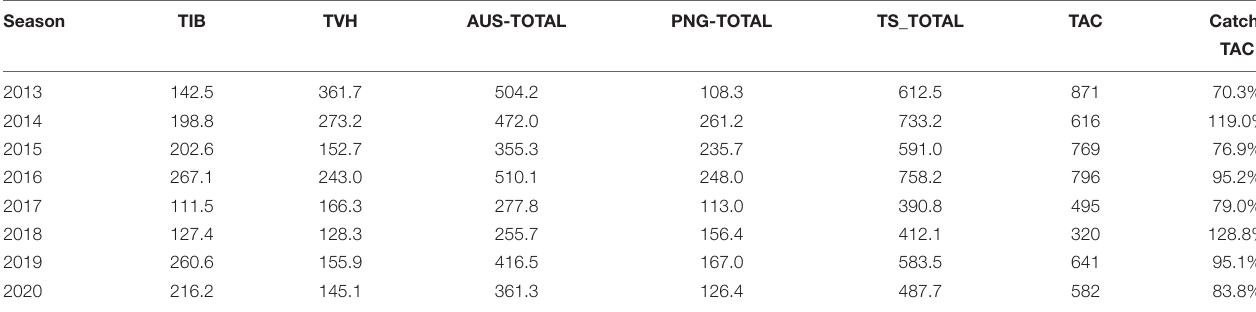
TABLE 1 | Summary of recent catch (t) per Torres Strait (TS) sector shown as a percentage of the Total Allowable Catch (TAC). Season TIB TVH AUS-TOTAL PNG-TOTAL TS_TOTAL TAC Catch/